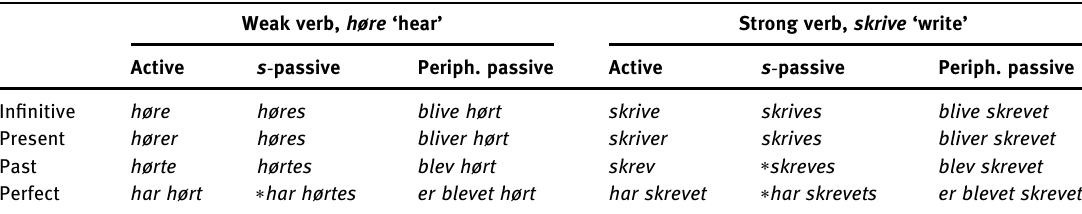
Table 1: Conjugation of weak and strong verbs Weak verb, høre ‘ hear ’ Strong verb, skrive ‘ write ’ Active s - passive Periph. passive Active s - passive Periph.